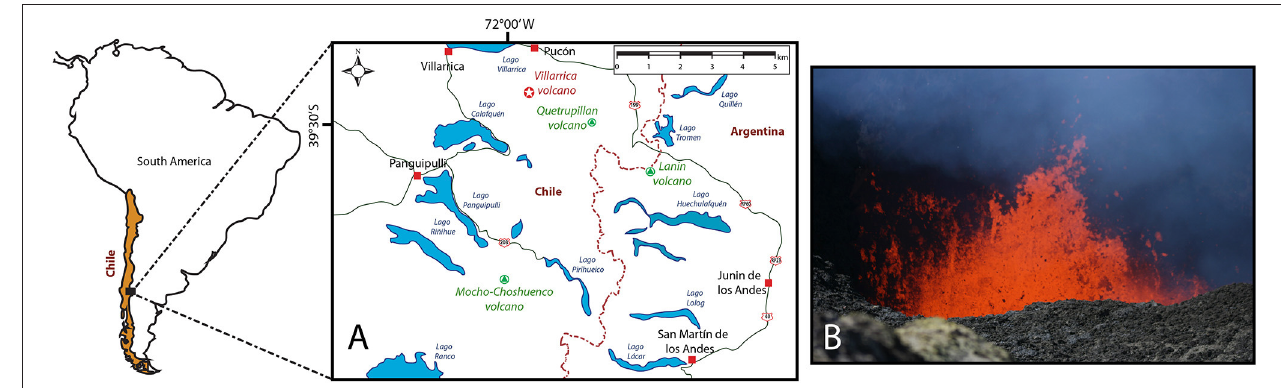
FIGURE 1 | Villarrica volcano. (A) Location of Villarrica and main neighboring cities and towns (red squares). Main roads are in green lines, the international border is in pale-red segmented line and lakes are clear blue bodies. (B) Typical background magmatic activity inside the crater of Villarrica. Picture by Patricio Arias in